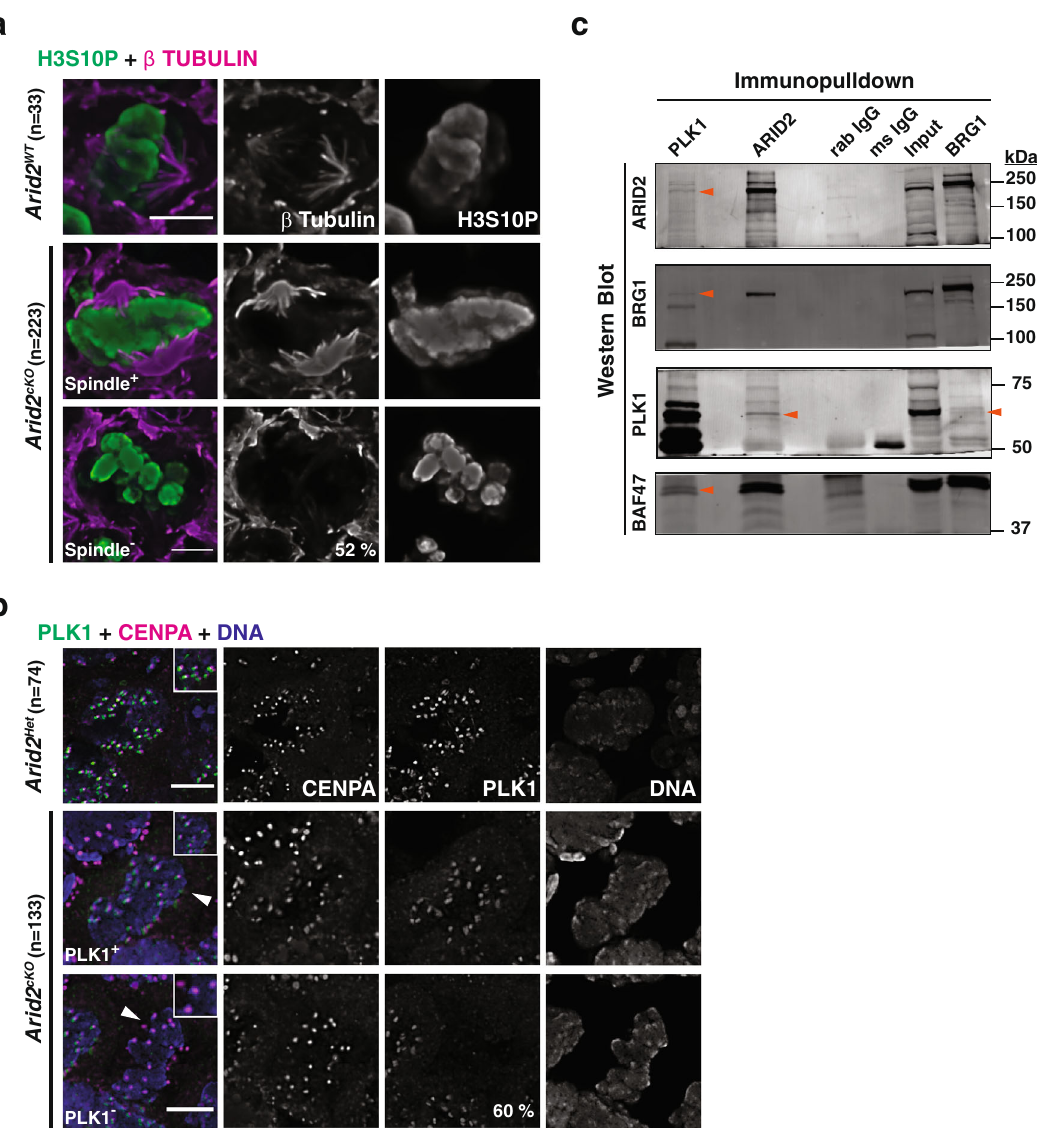
Fig. 2 ARID2 in fl uences spindle assembly and PLK1 association with kinetochore. a , b Metaphase-I spermatocytes from control and Arid2 cKO testes cryosections immunolabelled for: a H3S10P (green) and β -Tubulin (magenta), b PLK1 (green), CENPA (magenta), and counterstained with DAPI (blue). Arrowheads label metaphase-I spermatocytes and panel insets highlight centromeres. a , b Scale bars: 5 μ m, magni fi cation: 100x. Internal control (Spindle + /PLK1 + ) and mutant metaphase-I spermatocytes (Spindle − /PLK1 − ) were imaged from the same section. Number ( n ) of metaphase-I spermatocytes scored and proportion (%) of mutant cells are indicated. c PLK1, ARID2, and BRG1 Co-IPs from spermatocyte protein extracts. Immunoblotted proteins are labeled with orange arrowheads. ARID2 and BRG1 Co-IPs were reproducibly repeated three times along with two PLK1